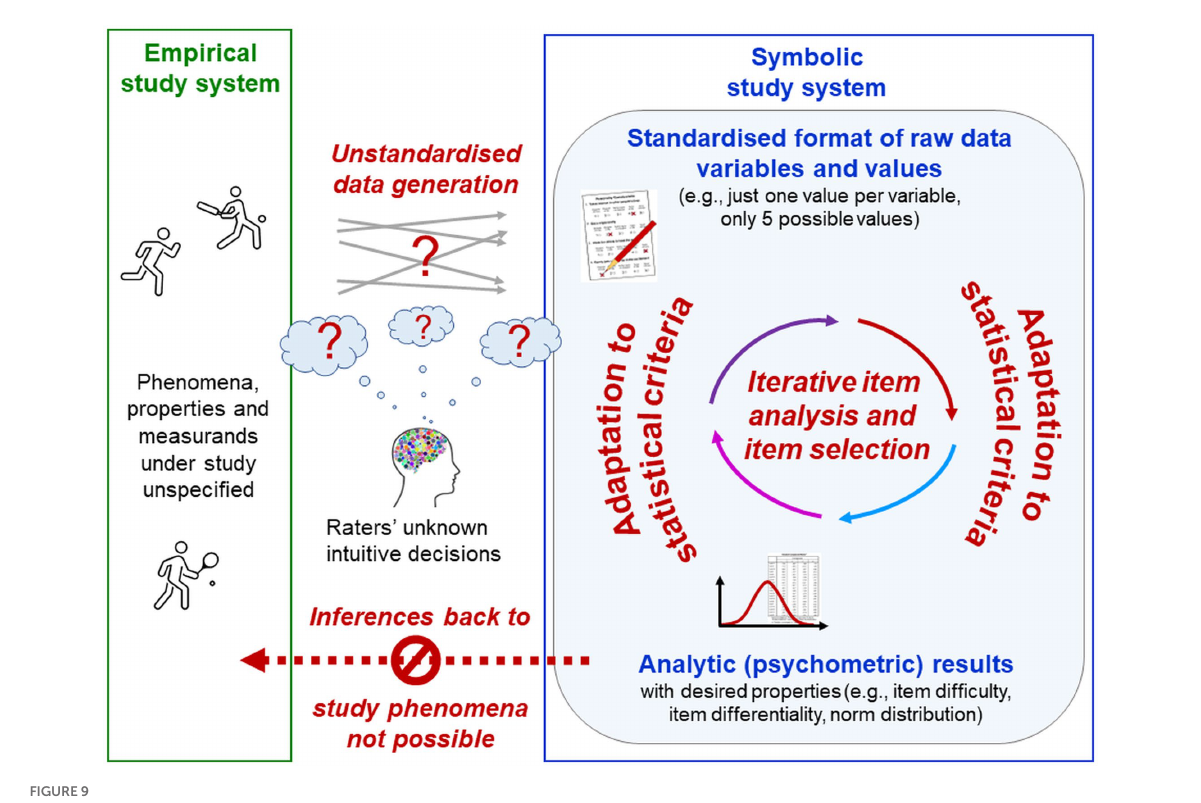
FIGURE 9 Result-based data generation enabling only pragmatic quantification. Psychometric ‘scale’ development involves iterative processes of item analysis and item selection, in which only those items are retained that allow the generation of data that differentiate well (e.g., item discrimination) and consistently between cases (reliability) and in ways considered meaningful (validity). This result-dependent data generation , however, aligns both the data generation and the analytical results to statistical criteria rather than to the study phenomena’s properties. This may be useful for pragmatic purposes but it precludes inferences from the analytical results obtained back to the phenomena, properties and measurands under study. These inferences are additionally compromised by the unknown intuitive decisions that raters are making when they generate the data before these are being psychometrically analysed and